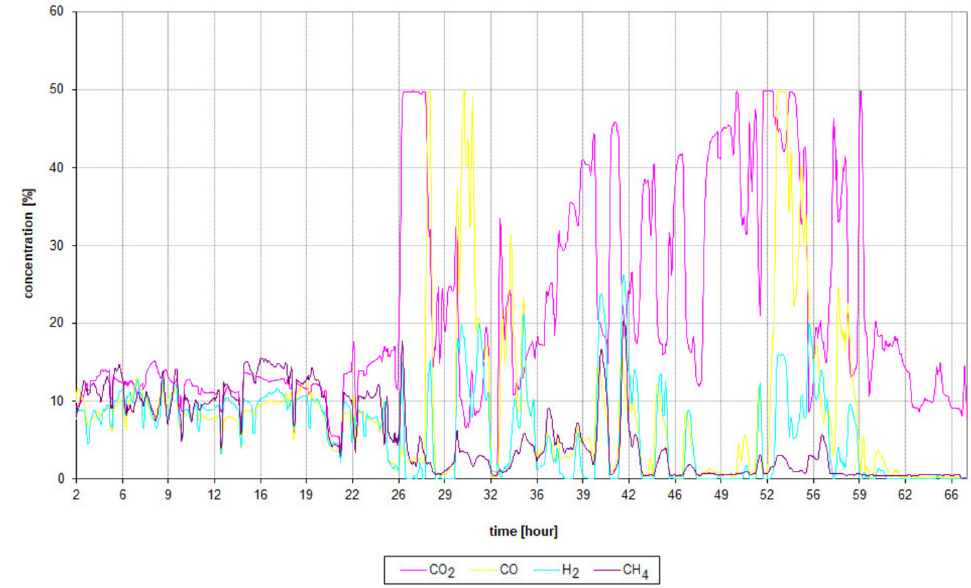
Figure 16. The syngas composition behavior during the second experiment.